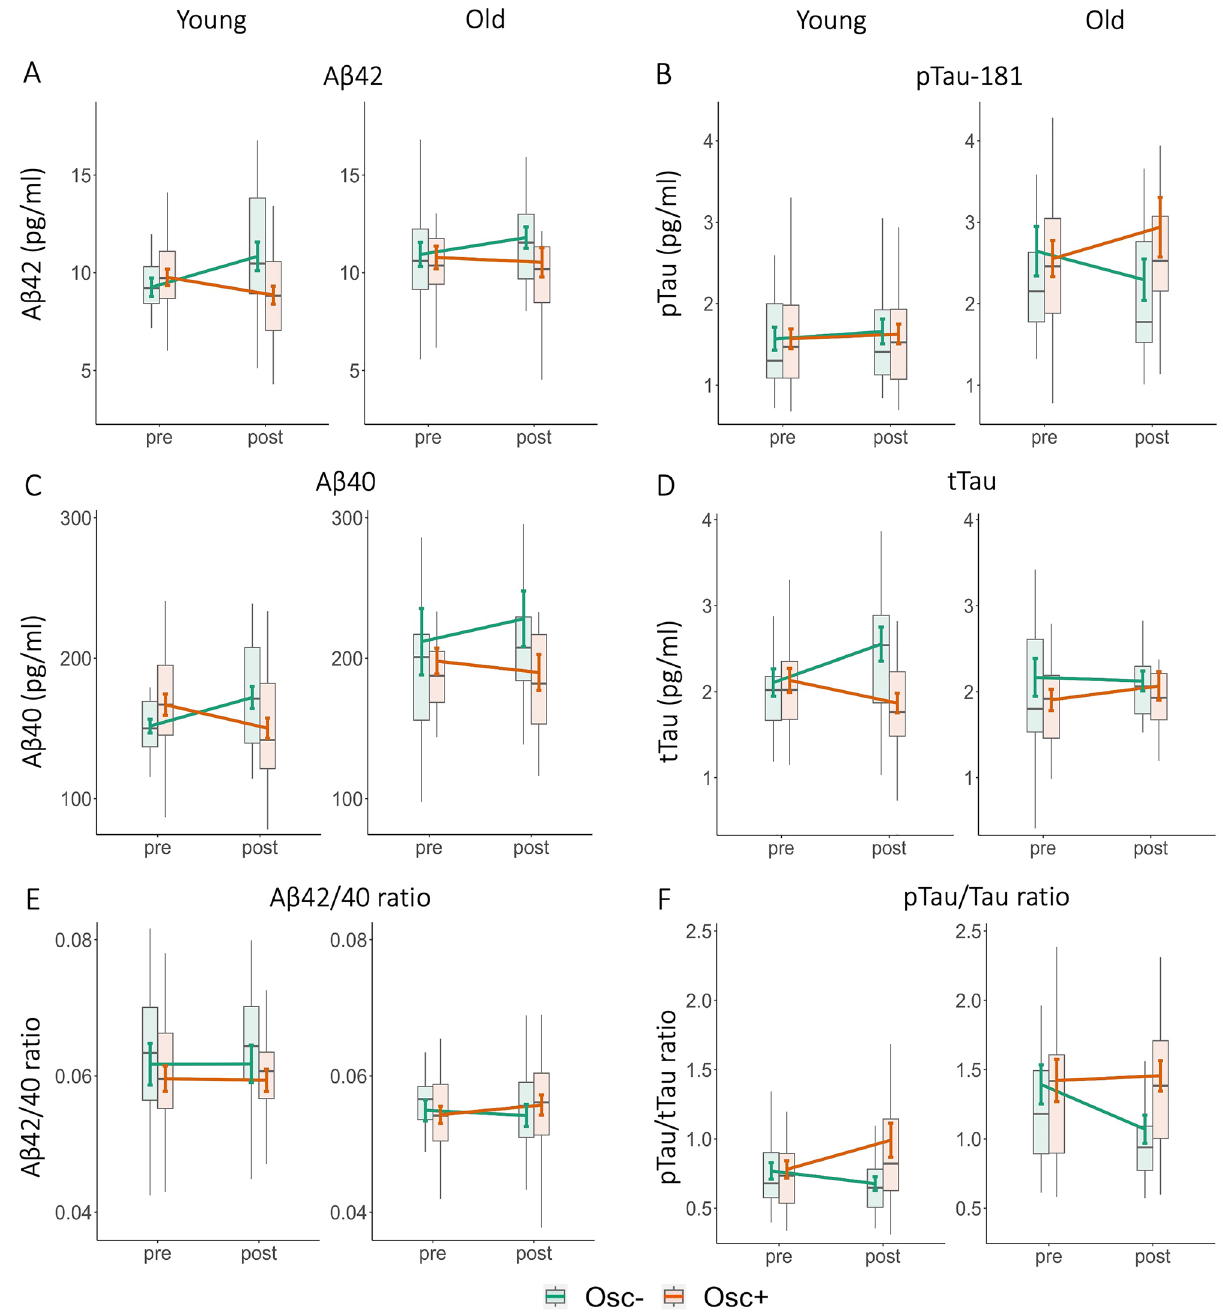
Figure 1. Intervention effect on Aβ and tau levels. Orange represents Osc+ and green represents Osc−. The upper and lower box boundaries indicate the 75th and 25th percentiles respectively. The gray horizontal bar inside each box shows a median value for the box, and the colored vertical line describes the mean and standard error. The outliers are included for the summary statistics but are not shown in the